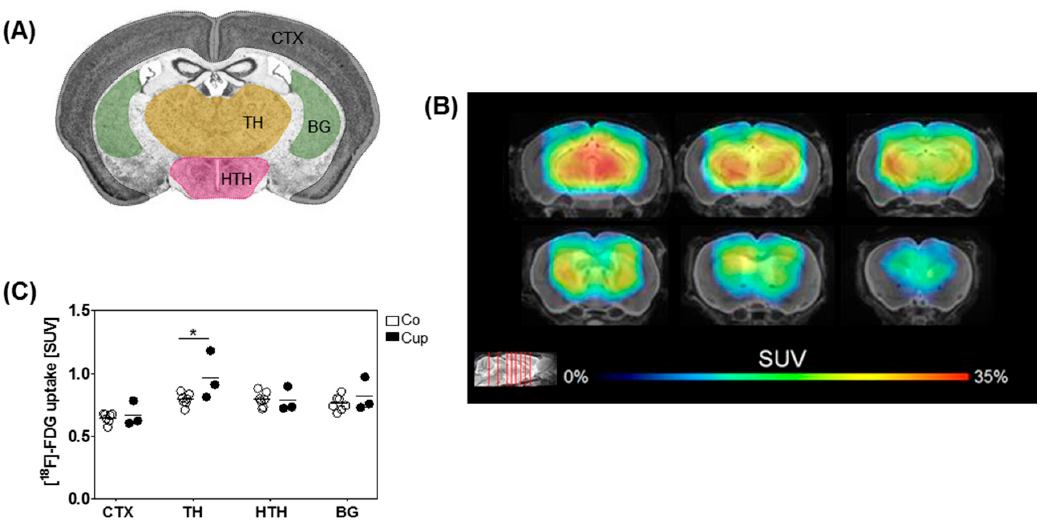
Figure 5. Altered [ 18 F]-fluoro-2-deoxy- d -glucose ([ 18 F]-FDG) ligand uptake after chronic cuprizone intoxication. ( A ) Schematic illustration of the different brain regions (cortex (CTX), thalamus (TH), hypothalamus (HTH), and basal ganglia (BG)), evaluated for [ 18 F]-FDG ligand uptake. ( B ) Cumulative heat map illustrating percentage increases of standardized uptake values (SUV) in cuprizone-treated mice relative to controls. ( C ) Quantification of the normalized [ 18 F]-FDG uptake in Co ( n = 7) and 12-week Cup mice ( n = 3). Data are shown as individual values and means per group (lines). Statistical analysis revealed significant differences between Co and Cup in ( C ) (TH, p = 0.03); * p < 0.05.